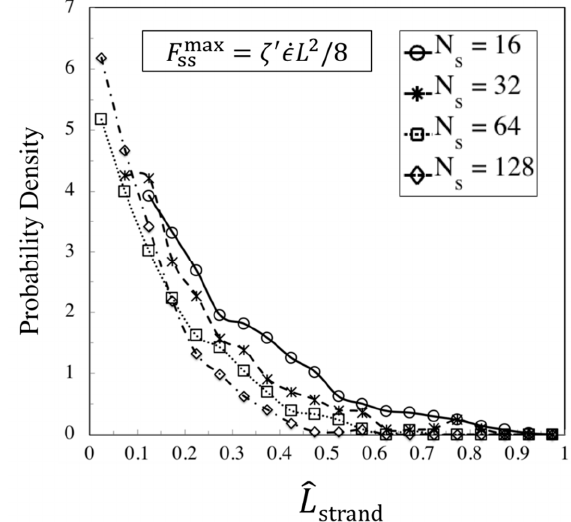
Figure 16. Strand length probability density for different chain lengths at Wi R = 32. Strand lengths are obtained at the transition strain corresponding to formation of the kinked state of each chain at Wi R = 32 .